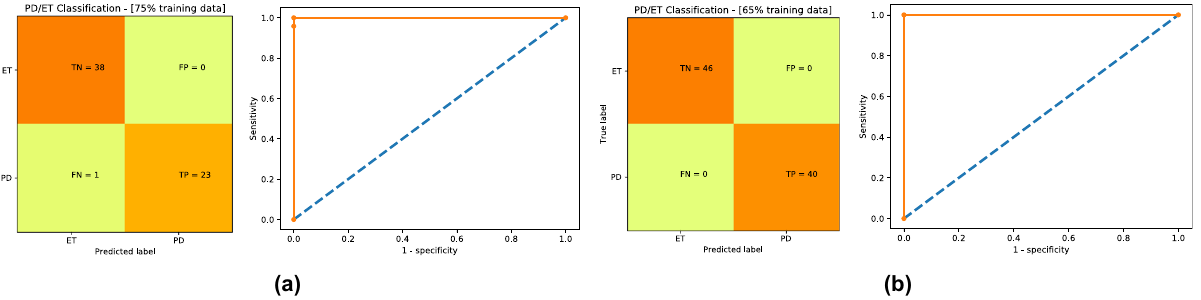
Figure 5. Confusion matrix and the ROC diagrams associated with the 2 winning frameworks for PD/ET classification. Please note that AUC stands for area under curve. Two winning paradigms of NeurDNet are when QDA classifiers is coupled with the first-stage classifier and ( a ) 75% and ( b ) 65% of the dataset is used for training process,